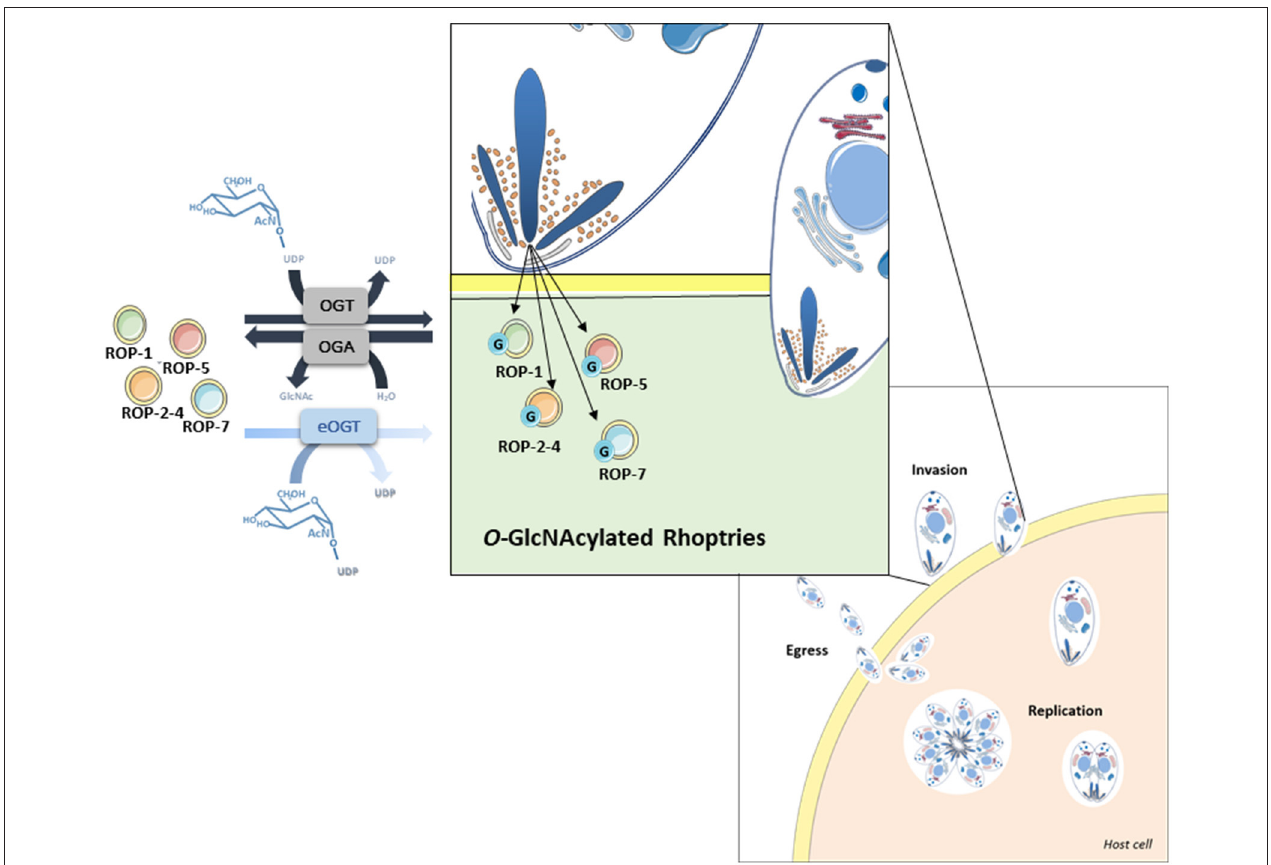
FIGURE 7 | O -GlcNAcylated rhoptries in Toxoplasma gondii and their putative involvement in infection.